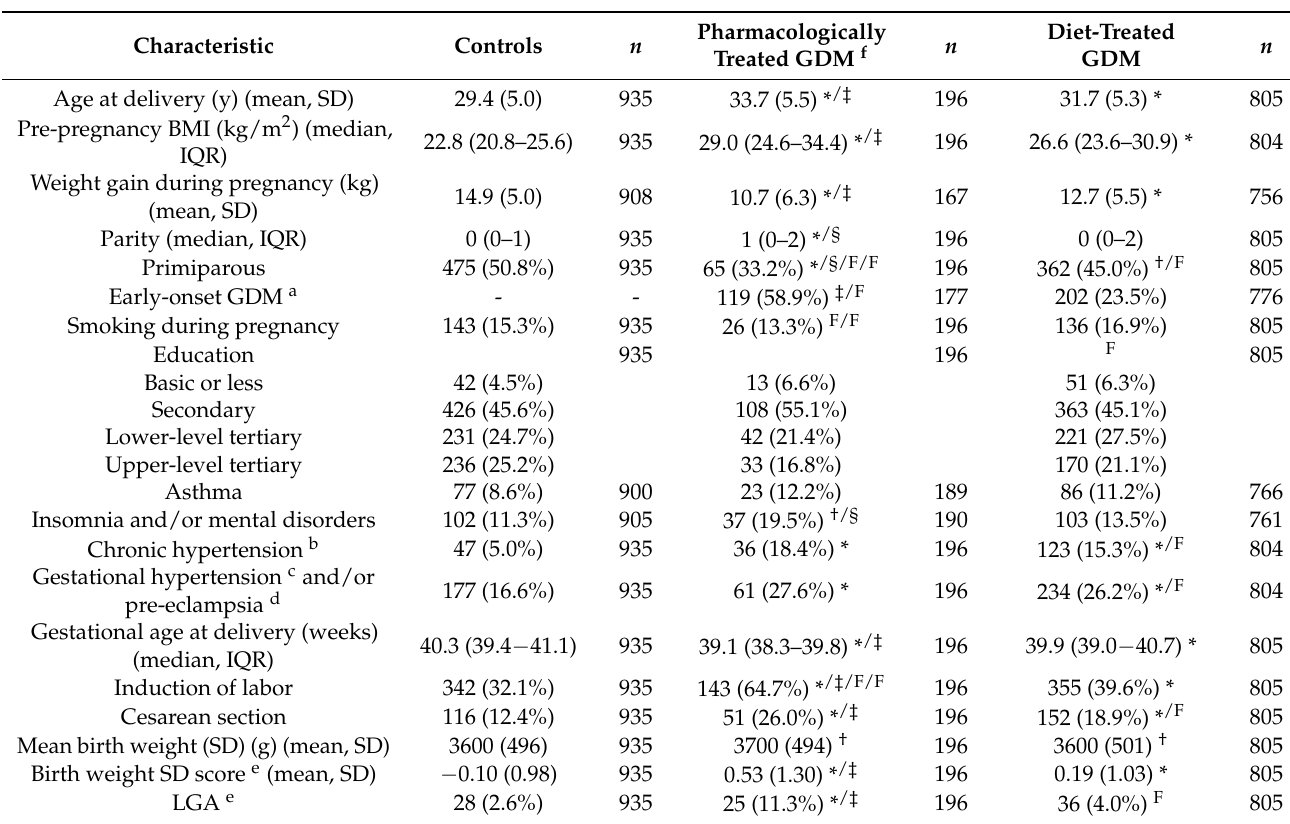
Table 2. Characteristics of the controls and women with pharmacologically treated and diet-treated gestational